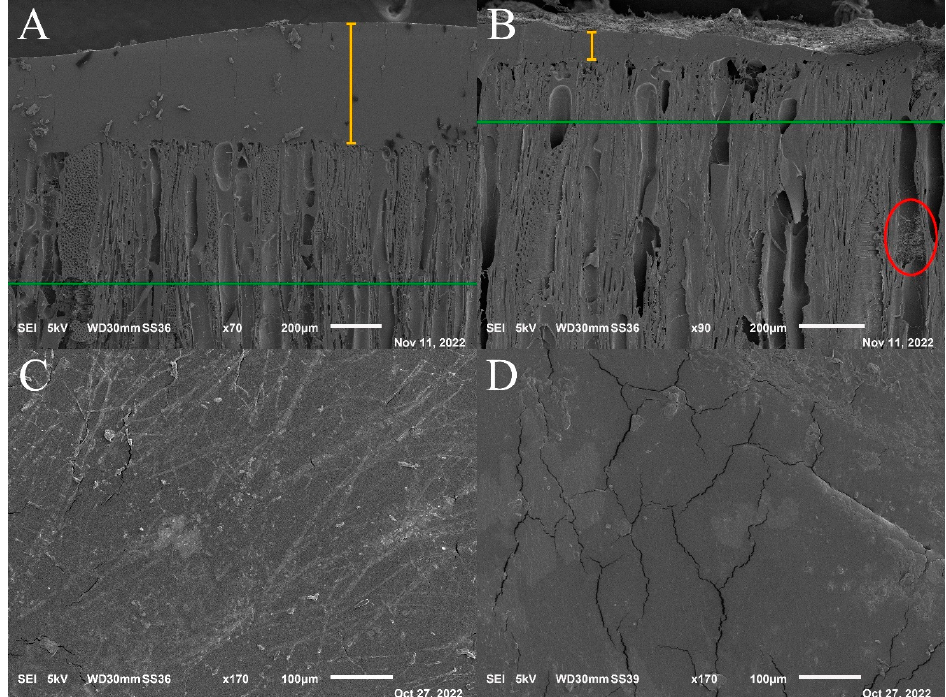
Figure 10. SEM observations. ( A ) CAB coated samples exposed to Tv. ( B ) CAB+CNC coated sample exposed to Tv. ( C ) CA+CNC coated samples exposed to Gt, stripes-shaped halo of the hyphae on the coating surface. ( D ) CA coated sample exposed to Gt, with light-grey halo on the coating surface, probably due to the metabolites produced by the fungus.